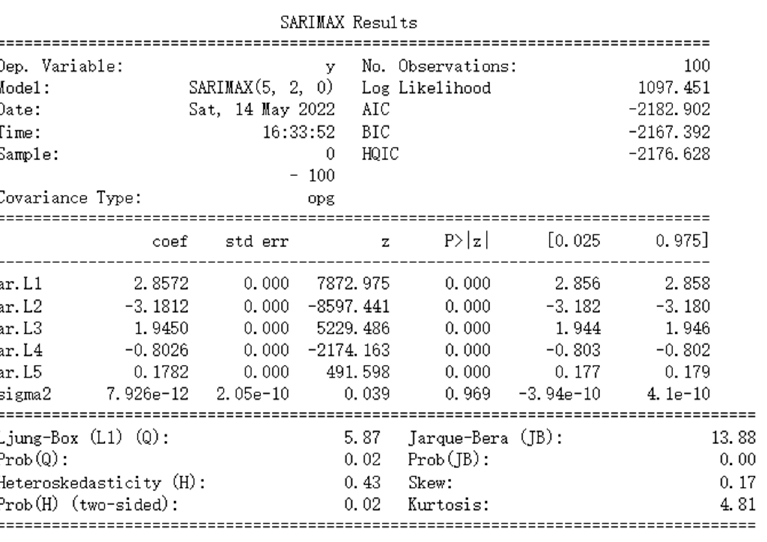
Figure 9. Static ARIMA result.